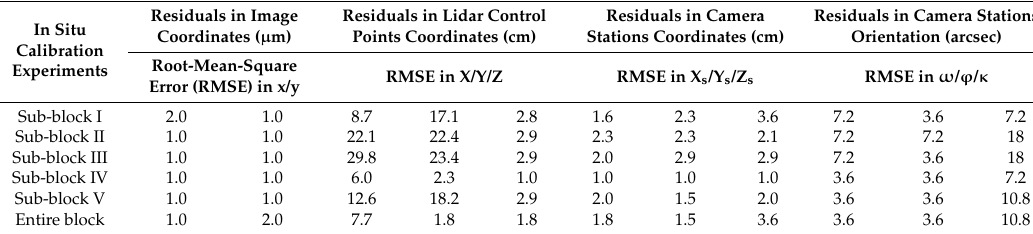
Table 1. Main results of the residual analysis performed from in situ camera calibrations. In Situ